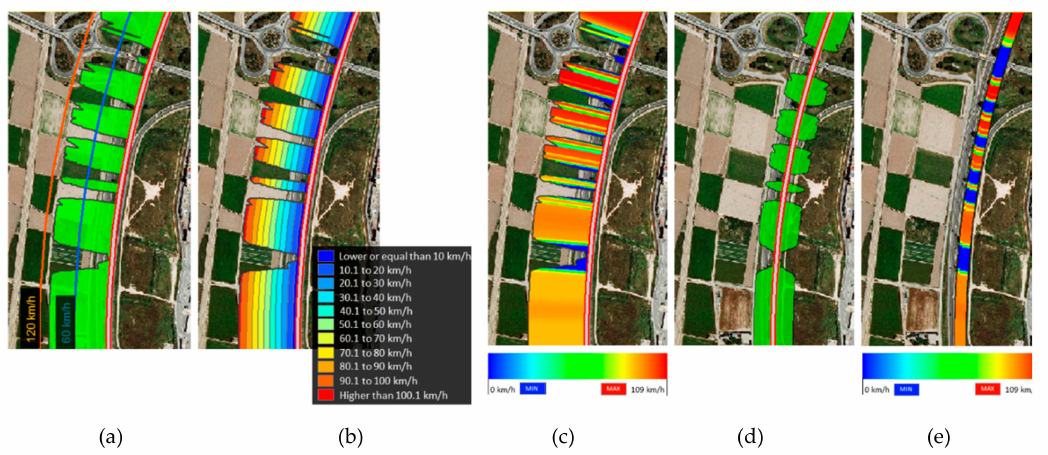
Figure 4. Speed of one driver in study area A. Di ff erent mapping results using geometric and color